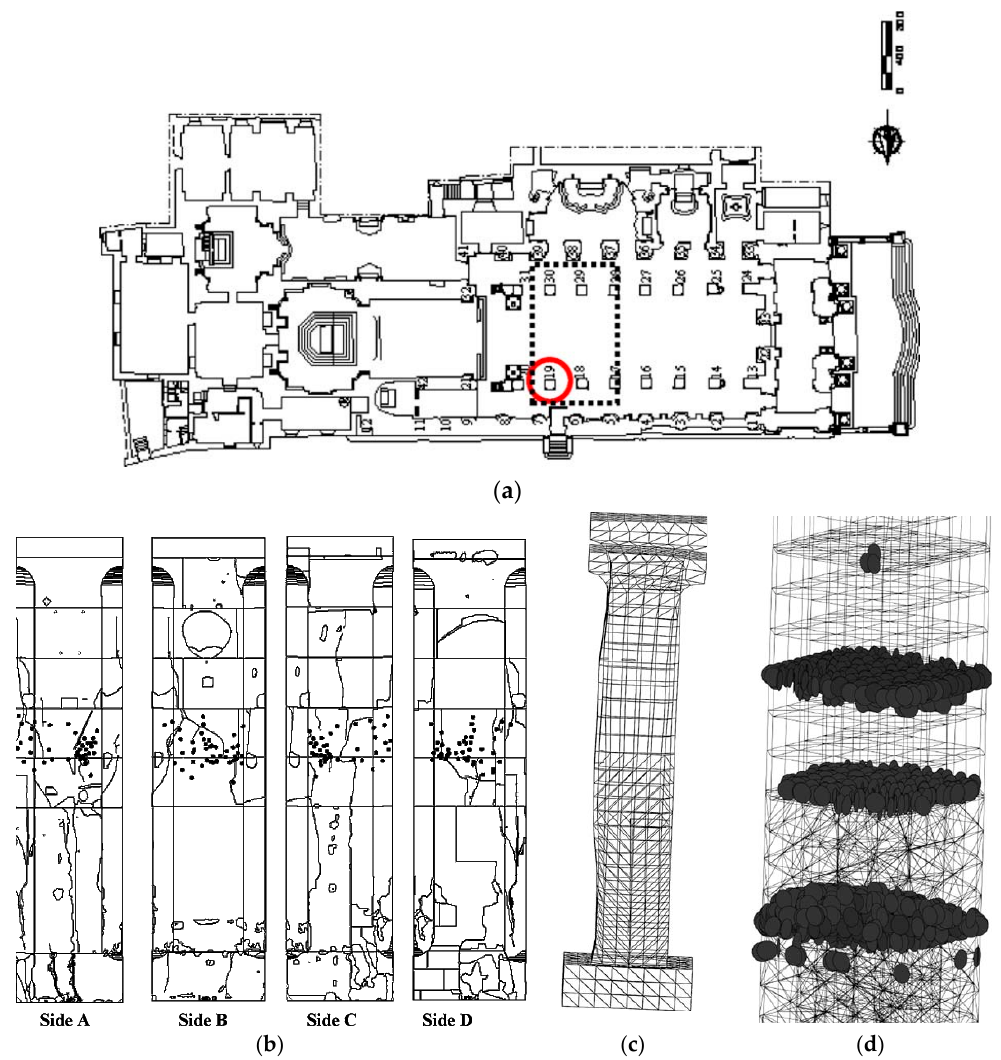
Figure 6. ( a ) Plan of the Syracuse Cathedral and most critical pillar; ( b ) cracking pattern and localization of AE sources; ( c ) deformed mesh due to the seismic load; ( d ) cracking in the pillar due to the seismic acceleration.